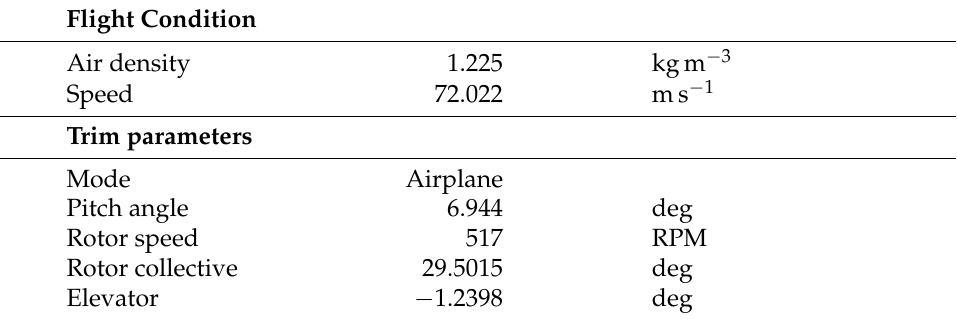
Table 9. Flight condition parameters used for roll maneuver simulation